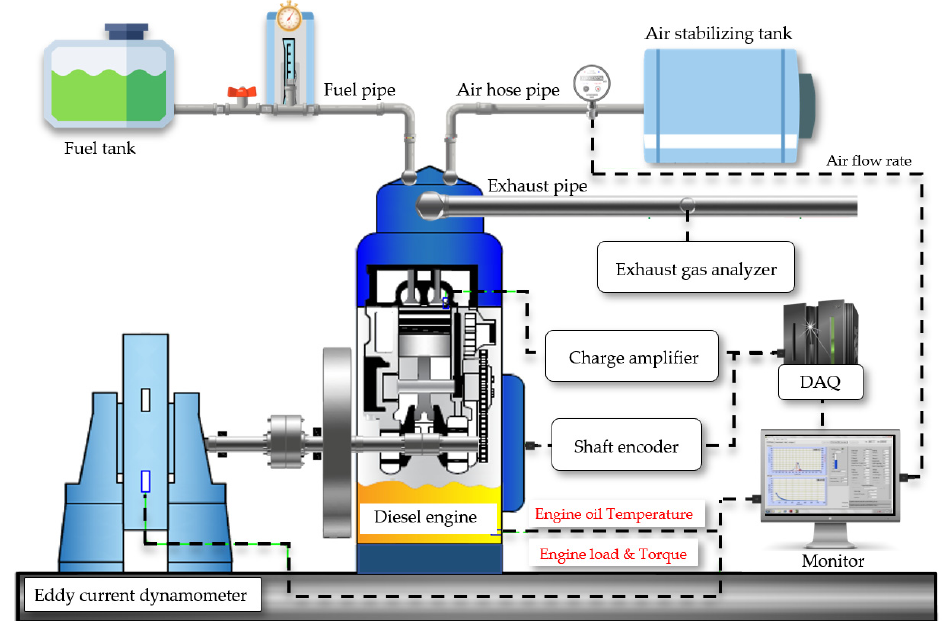
Figure 1. A schematic diagram of the experimental installation.